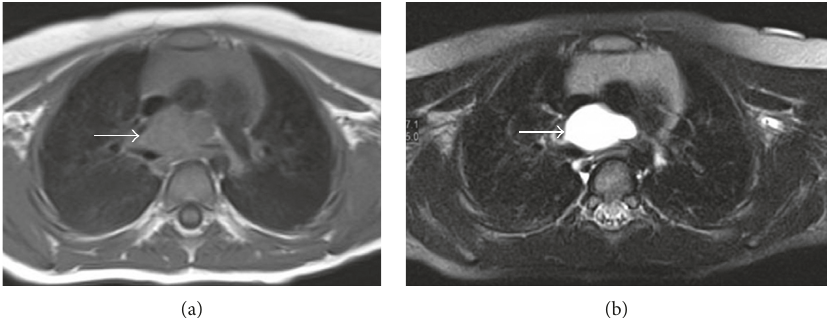
Figure 3: MRI of the chest showing lobulated mass lesion heterogeneously hypointense on T1-weighted images (arrow) (a), and hy- perintense on T2-weighted images (arrow) (b). The mass is in the middle mediastinum, at the level of the carina and adjacent to the trachea extending to the subcarinal region, causing compression on the carina and both main bronchi, more pronounced on the left main